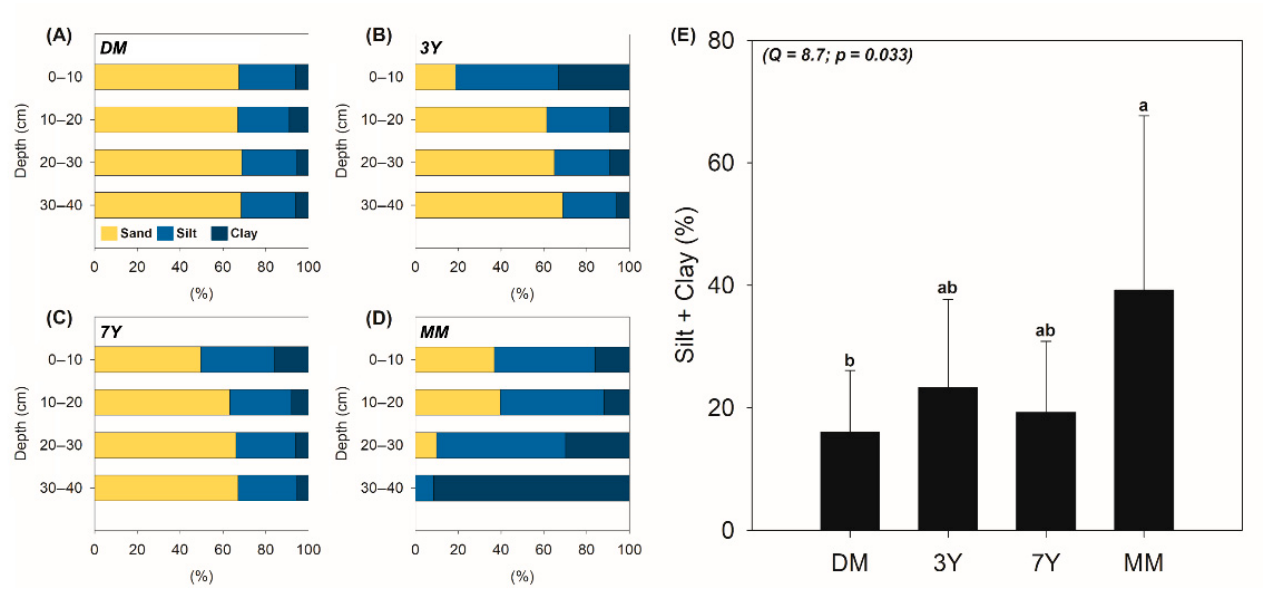
Figure 4. Sand, silt, clay contents for the four studied mangroves, i.e., ( A ) DM: degraded mangrove; ( B ) 3Y: 3-year-old mangroves; ( C ) 7Y: 7-year-old mangroves, and ( D ) MM: mature mangrove forest; ( E ) Statistical analysis of fine particle contents (silt + clay) in each study area. The different lowercase letters on the bars indicate a significant difference between the variables as determined by the Friedman test at a 5% probability level as Q values above the critical Q (7.8147) indicate statistical differences.